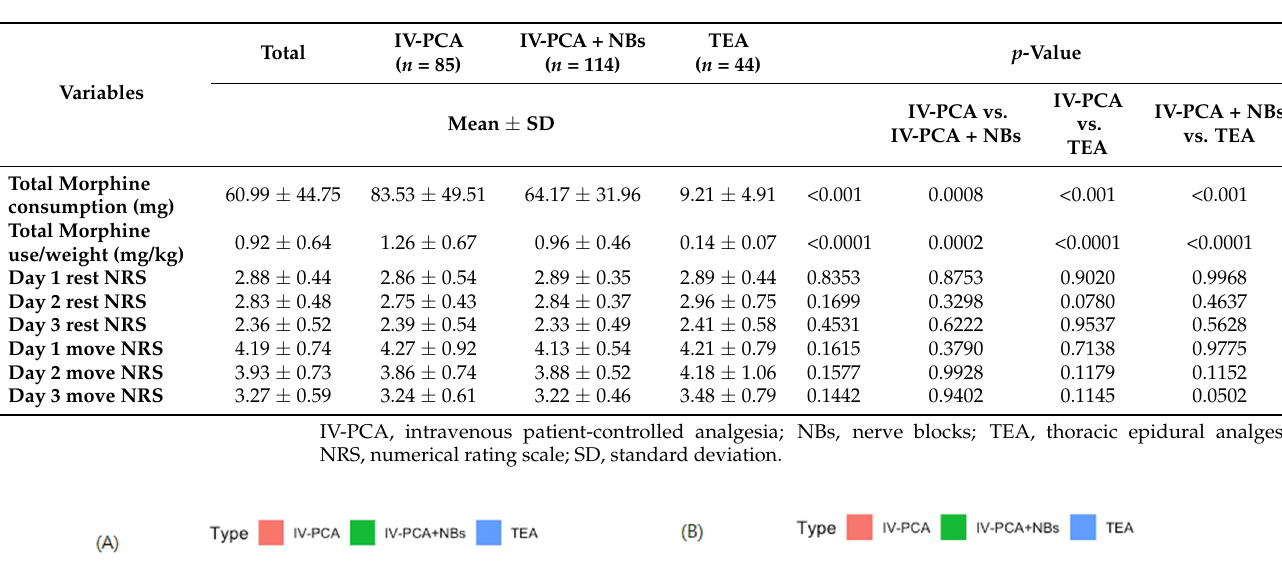
Table 3. Primary outcomes.